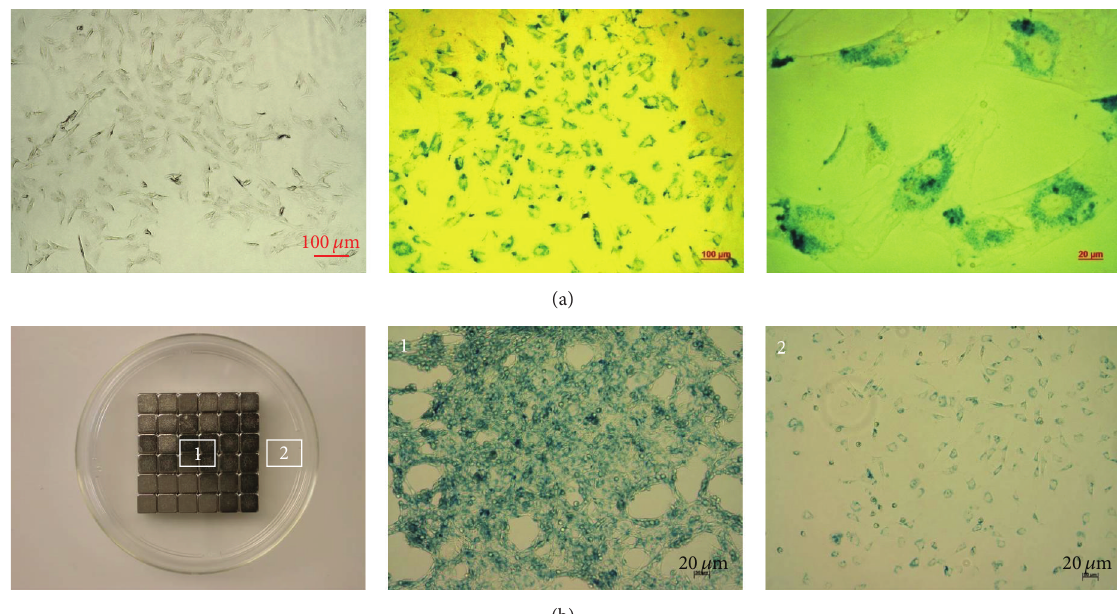
Figure 2: Magnetic accumulation of the SPIO ASCs in vitro . (a) There was heavy perinuclear distribution of blue-stained SPIOs in SPIO ASCs with the fibroblast-like morphology. (b) The “magnetic” SPIO ASCs were substantially attracted to the site where the magnet was positioned. Scale bar represents 20 𝜇 m, 50 𝜇 m, or 100 𝜇 m.